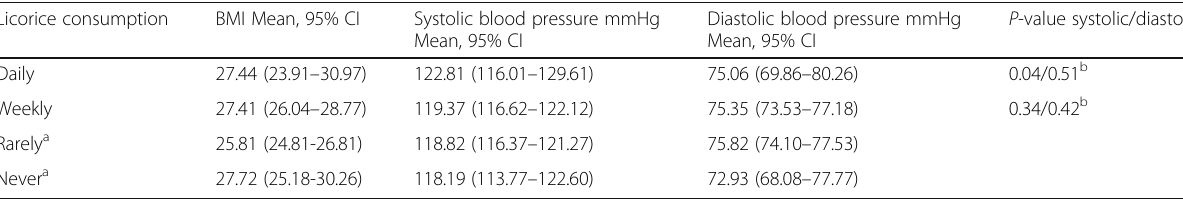
Table 5 Maternal blood pressure at gestational week 29 in relation to licorice